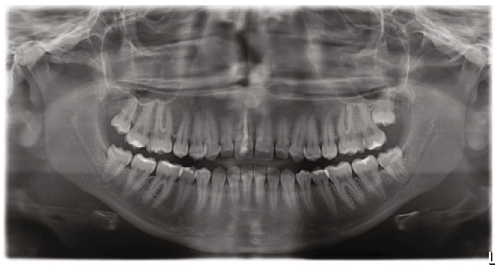
Figure 3: Pretreatment